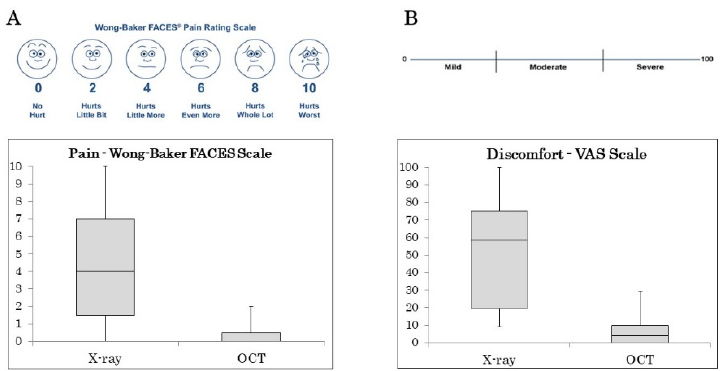
Figure 2. Statistical distributions of the Wong-Baker FACES scale pain scores ( A ) and VAS discomfort scale ( B ). Box plots are given for X-ray and OCT groups. The horizontal lines represent the medians and quartiles. The top and bottom of the vertical lines specify 1.5 times the interquartile range plus and minus the upper and lower quartiles, respectively.